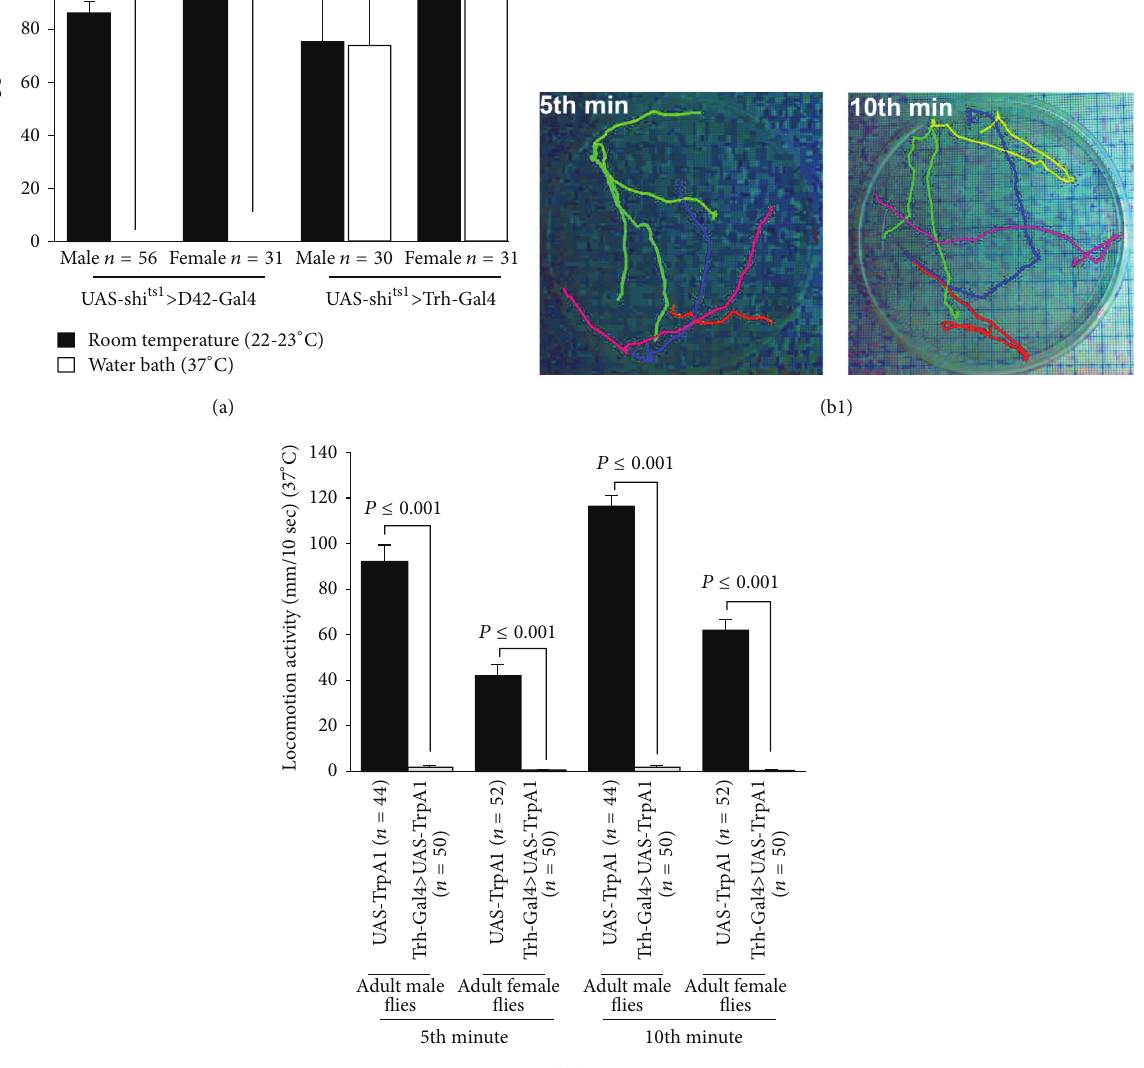
Figure10:Manipulationofactivityin5-HTergicneuronswithinadultflies.(a)Acuteinhibitionofneuromuscularsynapseneurotransmission by expressing shi ts1 in motor neurons (UAS- shi ts1 > D42-Gal4) significantly reduced climbing ability in adult female and male flies at restrictive temperature (37 ∘ C). This assay served as a proof of concept in the genetic crosses. However, acute blockage of serotonergic synaptic transmission (UAS- shi ts1 > Trh-Gal4 (III)) did not influence climbing ability in adult flies. Student’s 𝑡 -test was used to compare the climbing ability of the flies at room temperature (22-23 ∘ C) with the same flies after incubation in the water bath (37 ∘ C). (b1) Locomotion activity was recorded for 10 minutes in UAS-TrpA1 (control) and Trh-Gal4 (III) > UAS-TrpA1, which expressed TrpA1 in 5-HTergic neurons, flies at 37 ∘ C. The activity was analyzed for 10 seconds at the 5th minute and 10 seconds at the 10th minute. These two pictures show the locomotion activity of adult male flies (controls), 10sec of 5th and 10sec of 10th minute, respectively. (b2) Acute activation of 5-HTergic neurons in freely moving adults significantly reduced the locomotion activity in adult male and female flies. Mann-Whitney rank sum test was used for comparison between the groups. Data represented as mean ±